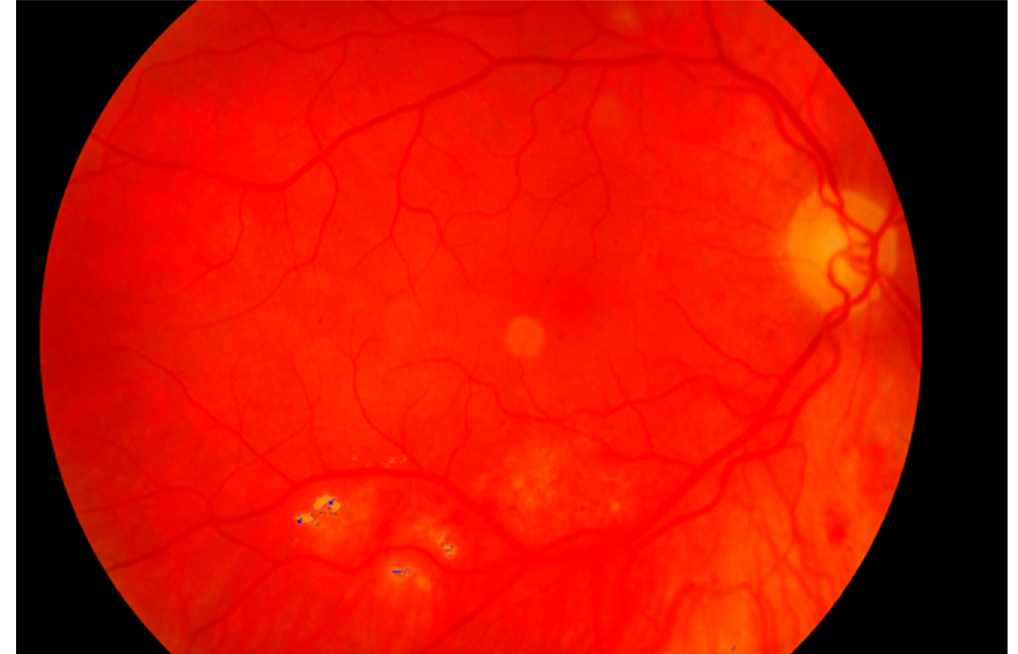
Figure 18. Retina color image with marked pathological changes.